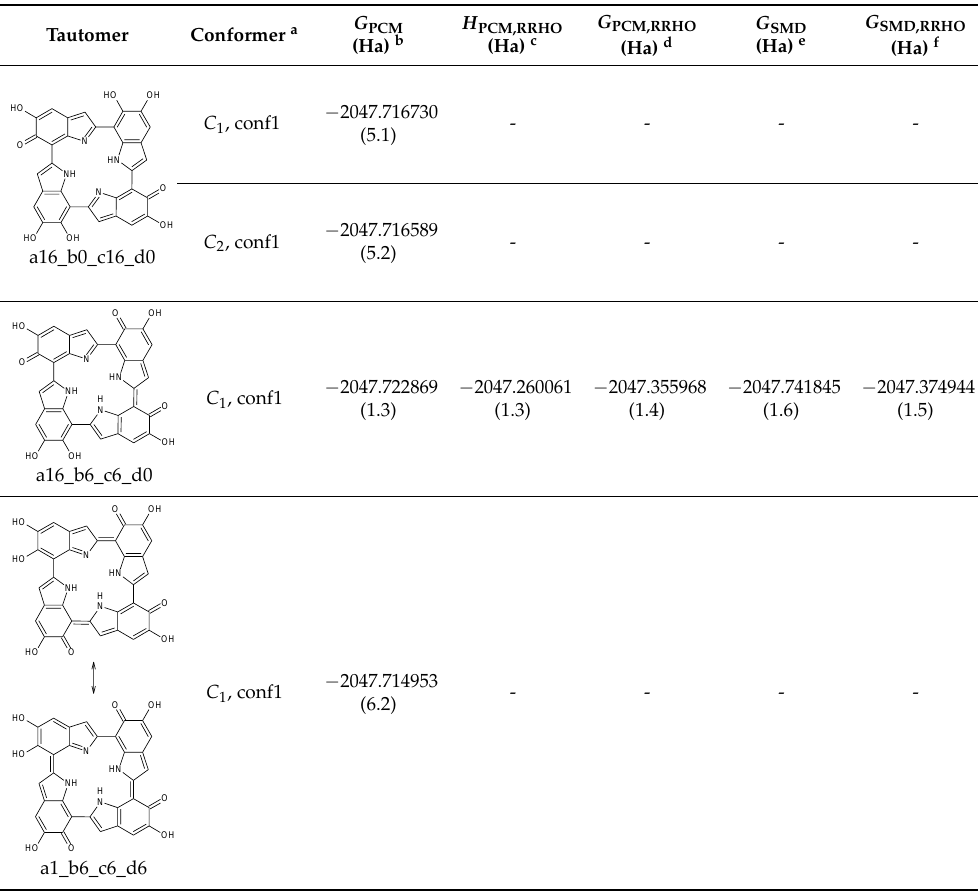
Table 11. KP-4e, neutral form in water.